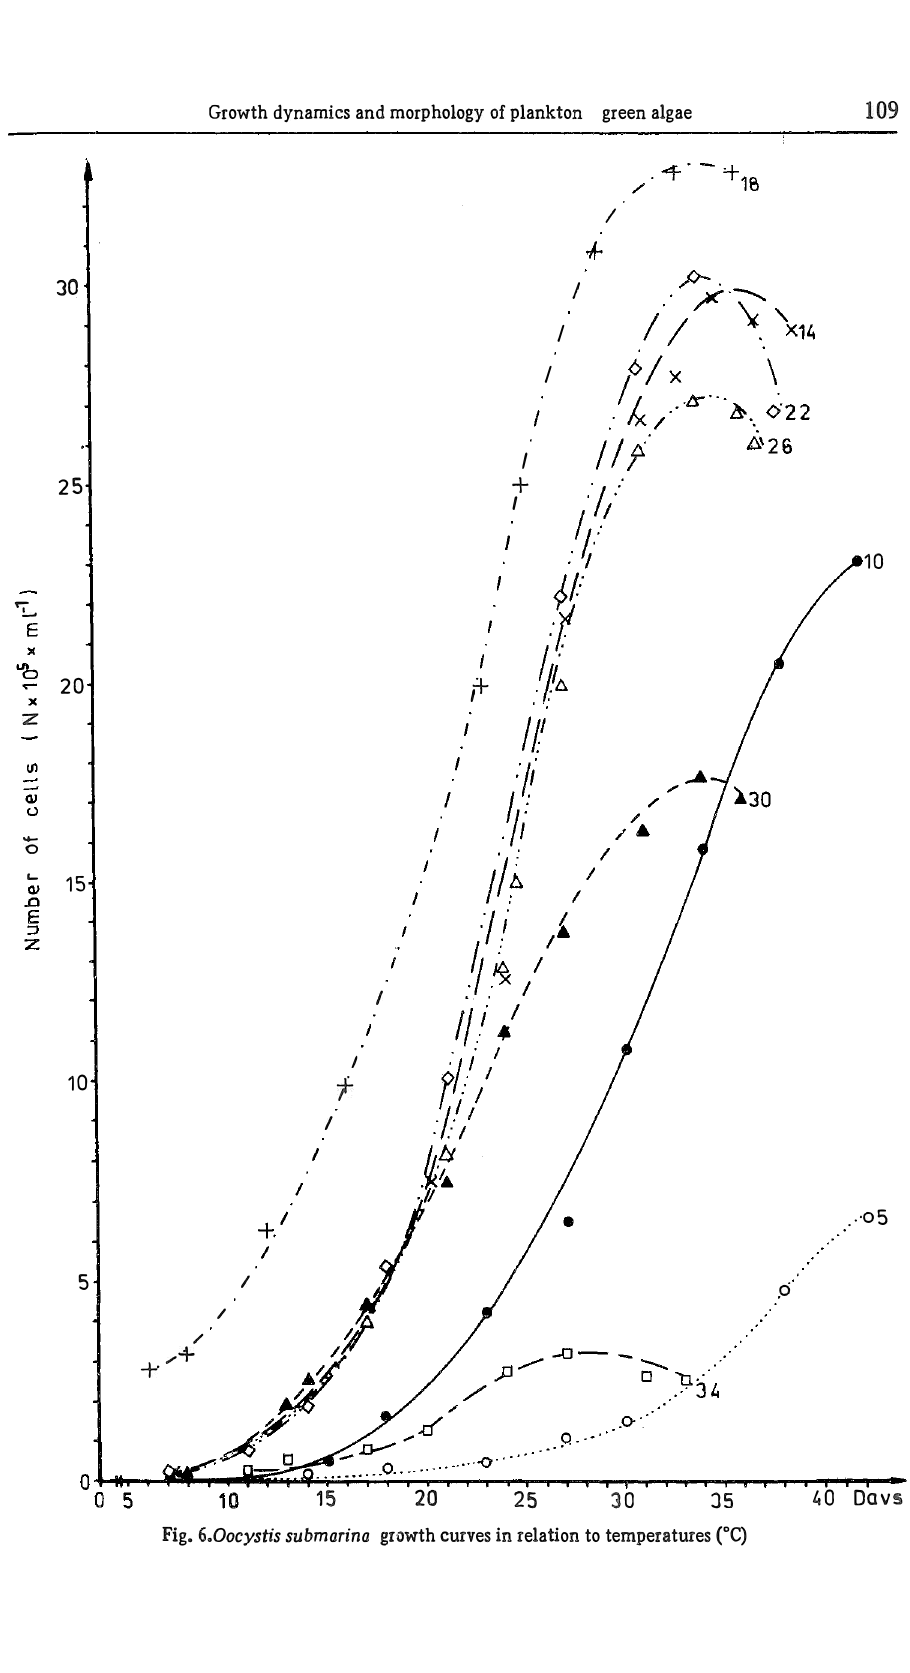
Fig. 6.0ocystis submarina grilwth curves in relation to tempenitures ( 0